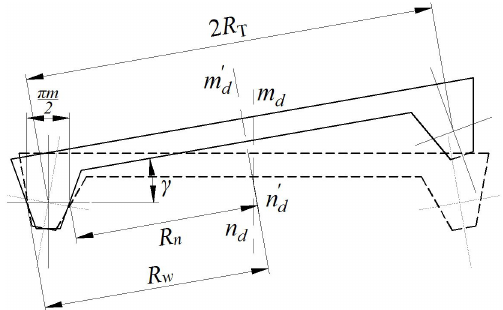
Figure 4. Installation position of a large cutter for inclined milling.